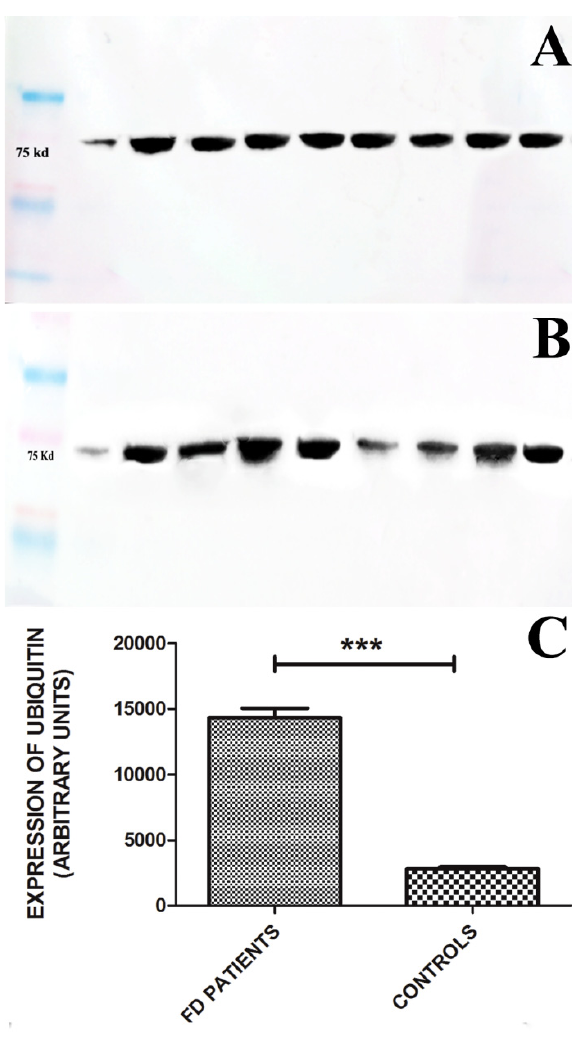
Figure 4. Panel ( A , B ): Western blot analysis of Ubiquitin in 16 out of 17 patients with FDCM, molecular weight 75 Kd. Panel ( A ): Lane1 = Markers; Lane 2 = Control; Lane 3 = patient 1; Lane 4 = patient 2; Lane 5 = patient 3; Lane 6 = patient 4; Lane 7 = patient 5; Lane 8 = patient 6; Lane 9 = patient 7; Lane 10 = patient 8. Panel ( B ): Lane 1 = Markers; Lane 2= Control; Lane 3 = patient 9; Lane 4 = patient 10; Lane 5 = patient 11; Lane 6 = patient 12; Lane 7 = patient 13; Lane 8 = patient 14; Lane 9 = patient 15; Lane 10 = patient 16; Panel ( C ): Graphs report western blot of Ubiquitin in 16 out of 17 patients and show 4.6-fold increase in Ubiquitin values vs. controls (13,284 ± 1723 vs. 2870 ± 690, p < 0.001). *** = p < 0.001.